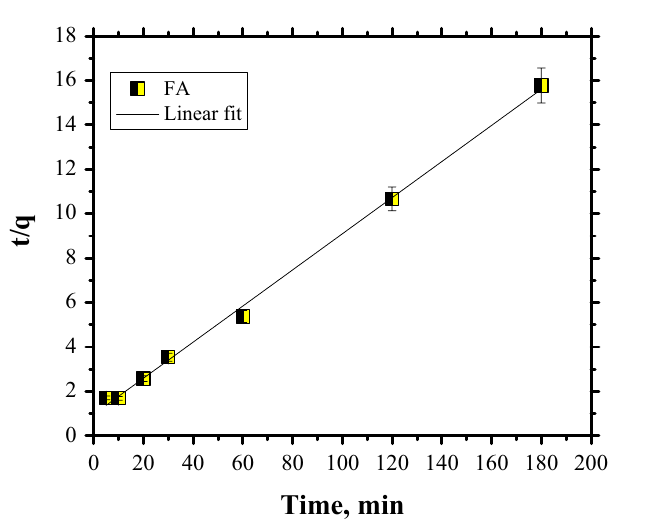
Figure 12. PSO kinetics of Congo Red dye